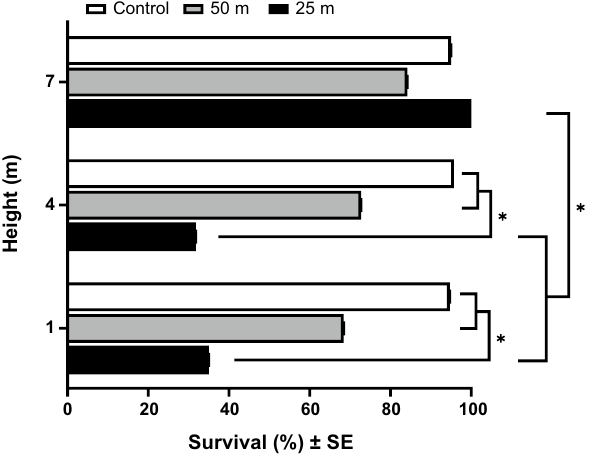
Figure 4. Effect of malathion on adult butterflies (N = 184 total) at different roosting heights and distances from adulticide spray route. Various species of butterfly (Nymphalidae, Pieridae and Papilionidae) were included. Asterisks indicate significant differences between groups ( p < 0.05), using GLM with binominal distribution.